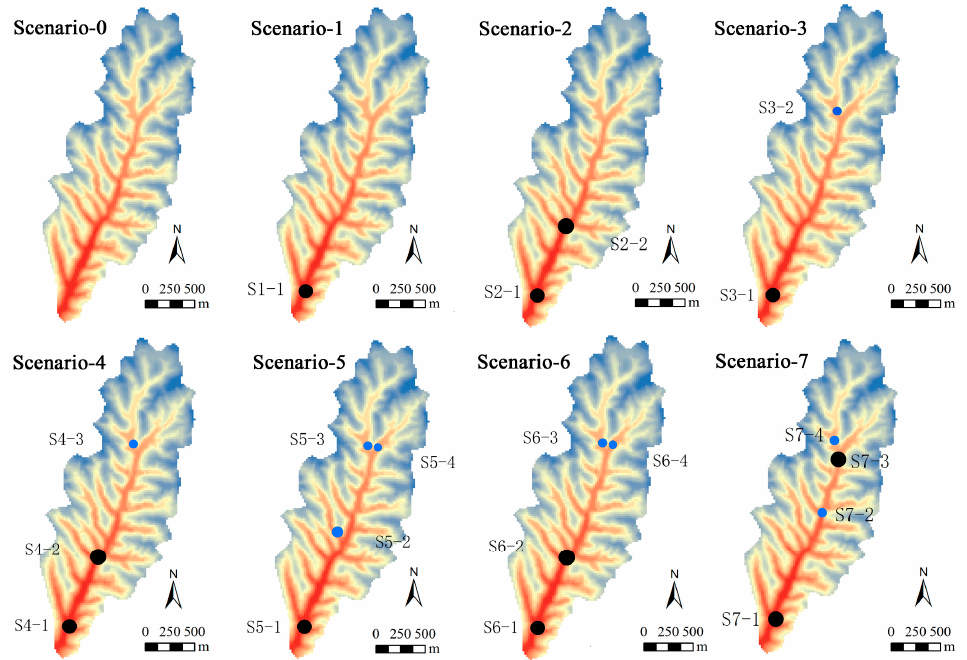
Figure 2. Check dam systems under different deployment strategies. Note that scenario-7 is the current deployment strategy of Shejiagou catchment.